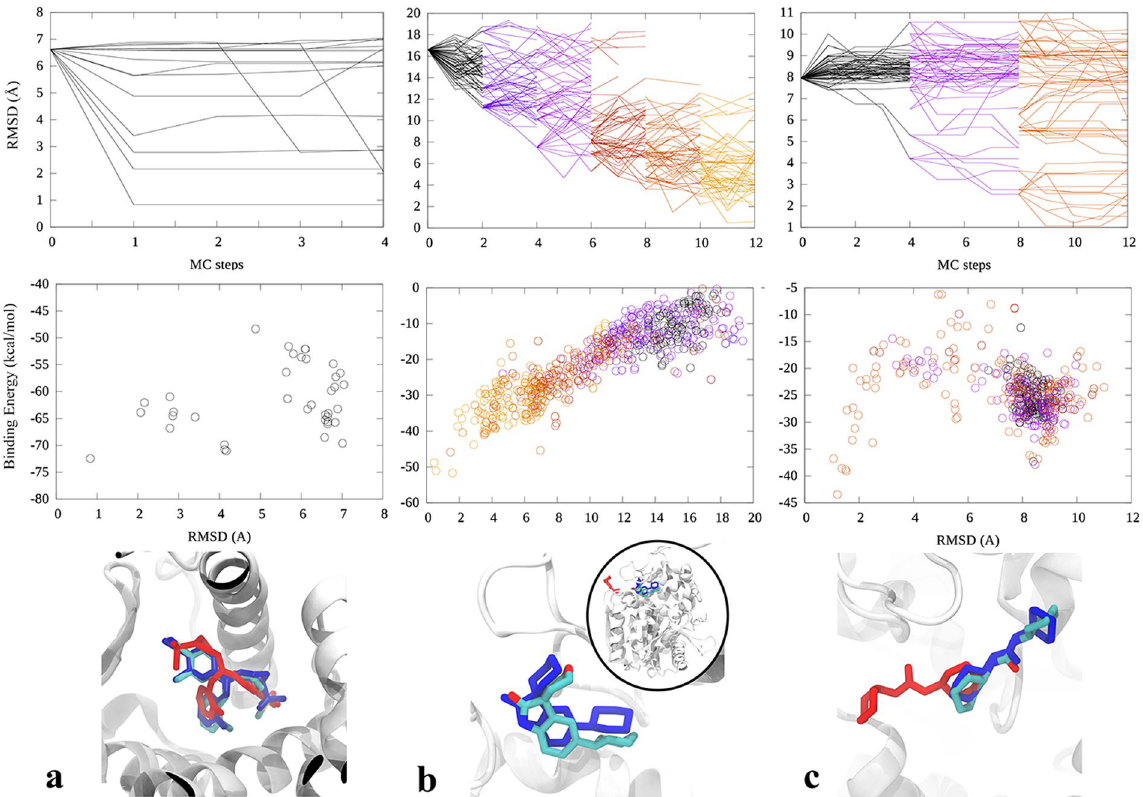
Figure 6. Induced-fit docking studies. ( a ) PR system: protein structure from PDB ID:1A28 and ligand structure from PDB ID:3KBA. ( b ) sHE system: protein structure from PDB ID:5AKE and ligand structure from PDB ID:5AM4. (c) sHE system: protein structure from PDB ID:5ALX and ligand structure from PDB ID:5AI5. In the upper panels we show the RMSD evolution along the simulation, in the middle ones the binding energy for the different RMSD values, and in the lower panels the native structure (atom-type colored), the lowest binding energy ligand structure (blue) and the starting ligand structure (red). Notice that in panel (b) the initial docking structure is slightly outside the active site (shown in the